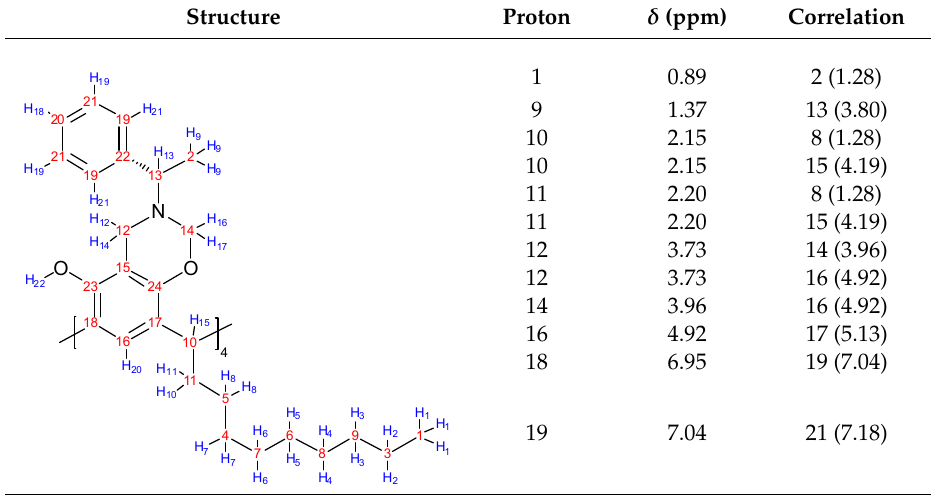
Table 1. Principal correlations for compound 5 in the COSY spectrum. Structure Proton δ (ppm) Correlation